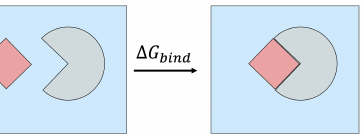
Figure 2. Binding a ligand (shown in red) to a protein receptor (shown in grey) in a box of solvent (shown in blue) releases free energy of ∆ G bind . A negative value of ∆ G bind indicates that spontaneous binding occurs, and the magnitude of ∆ G bind characterizes the binding strength